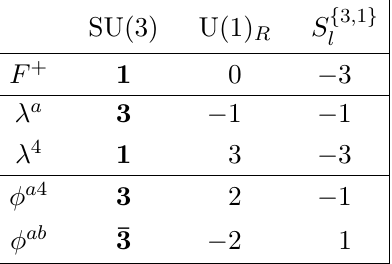
S-fold operator (in units of 2 (cid:25)=k ) and the l